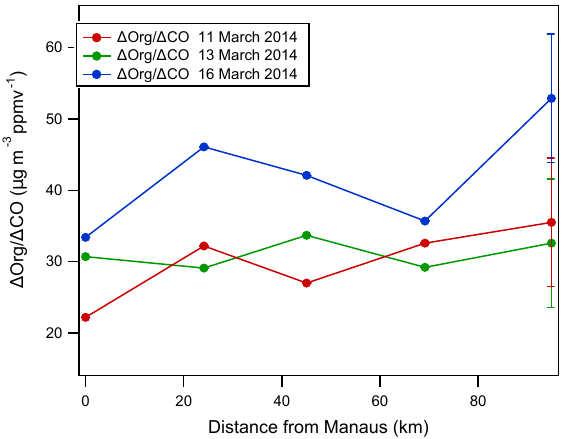
Figure 8. (cid:49) org /(cid:49) CO measurements in the plume as a function of distance from Manaus for 11, 13, and 16 March 2014. A represen- tative error bar is shown for each set of measurements. Mean wind speeds were 5.8, 7.3, and 4.6ms − 1 on 11, 13, and 16 March, re- spectively. Collectively, the data capture approximately the first 4– 6.5h of the plume